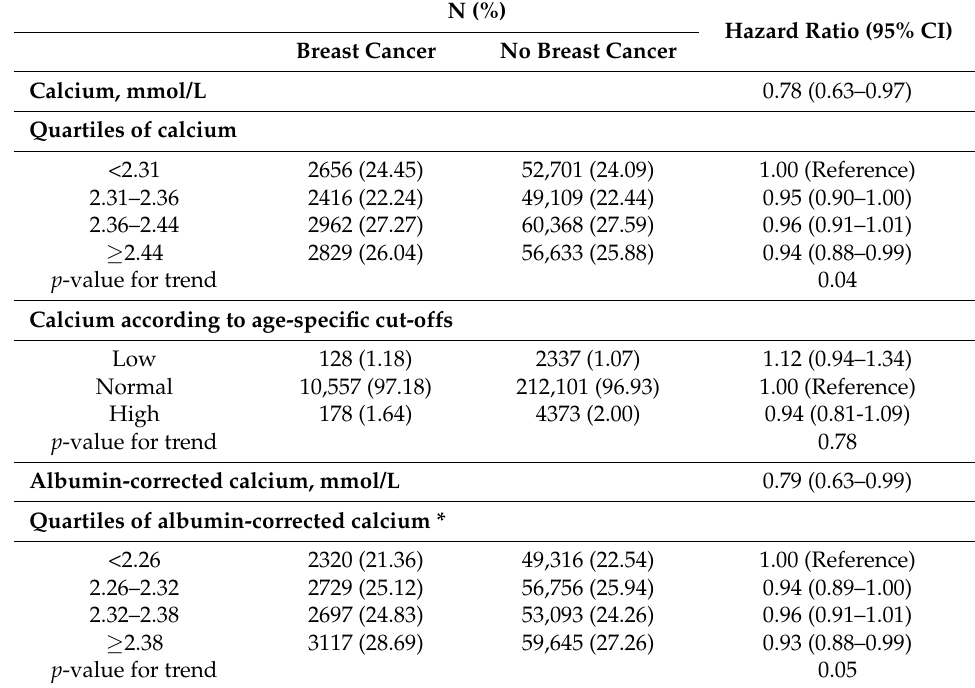
Table 2. Association between serum total calcium (age-specific and albumin-corrected) and risk of breast cancer. All models are adjusted for age, education, parity, history of fractures, Charlson Comorbidity Index, and season at index